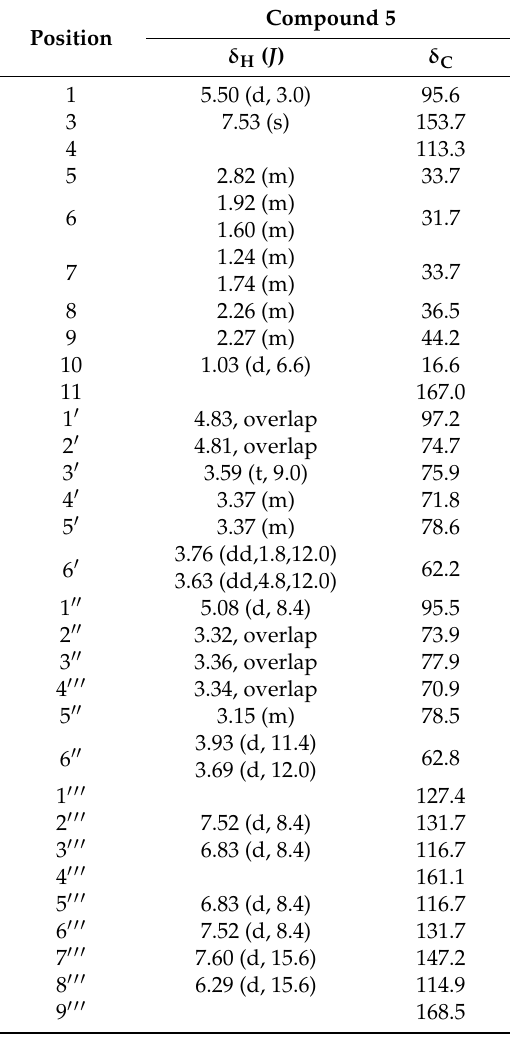
Table 2. 1 H- and 13 C-NMR data for 5 , measured at 1 H (600 MHz), and 13 C (150 MHz), CD 3 OD.